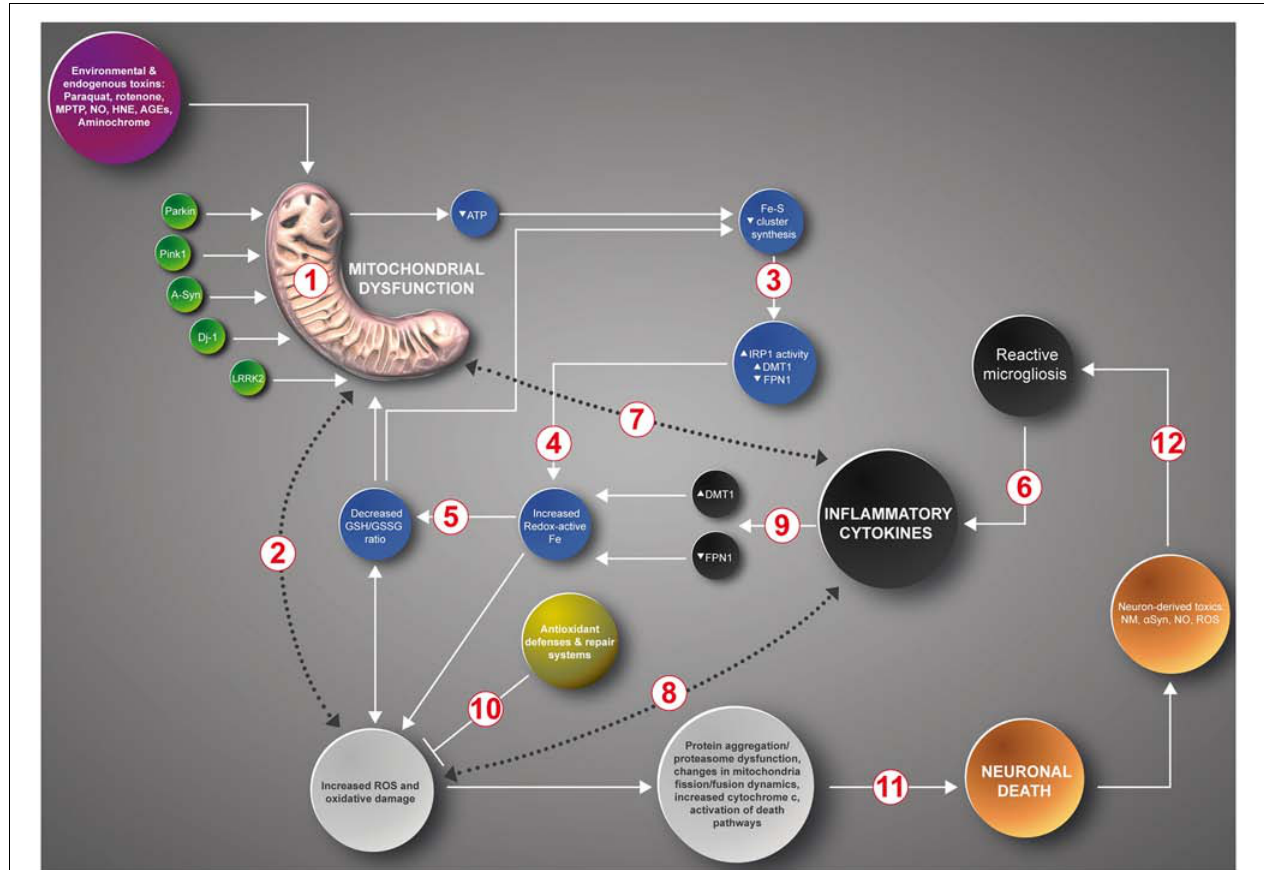
FIGURE 2 | A positive feedback loop in the death of neurons in PD. Inhibition of mitochondrial complex I by endogenous or exogenous toxins or mutations in PD genes Parkin, Pink 1, Alpha-synuclein, DJ-1 or LRRK2 generates a multifactorial positive feedback loop. In this loop, complex I inhibition results in iron accumulation driven by decreased Fe-S cluster synthesis, IRP1 activation, increased DMT1 and TfR1 expression and decreased FPN1 expression, increased ROS levels and decreased